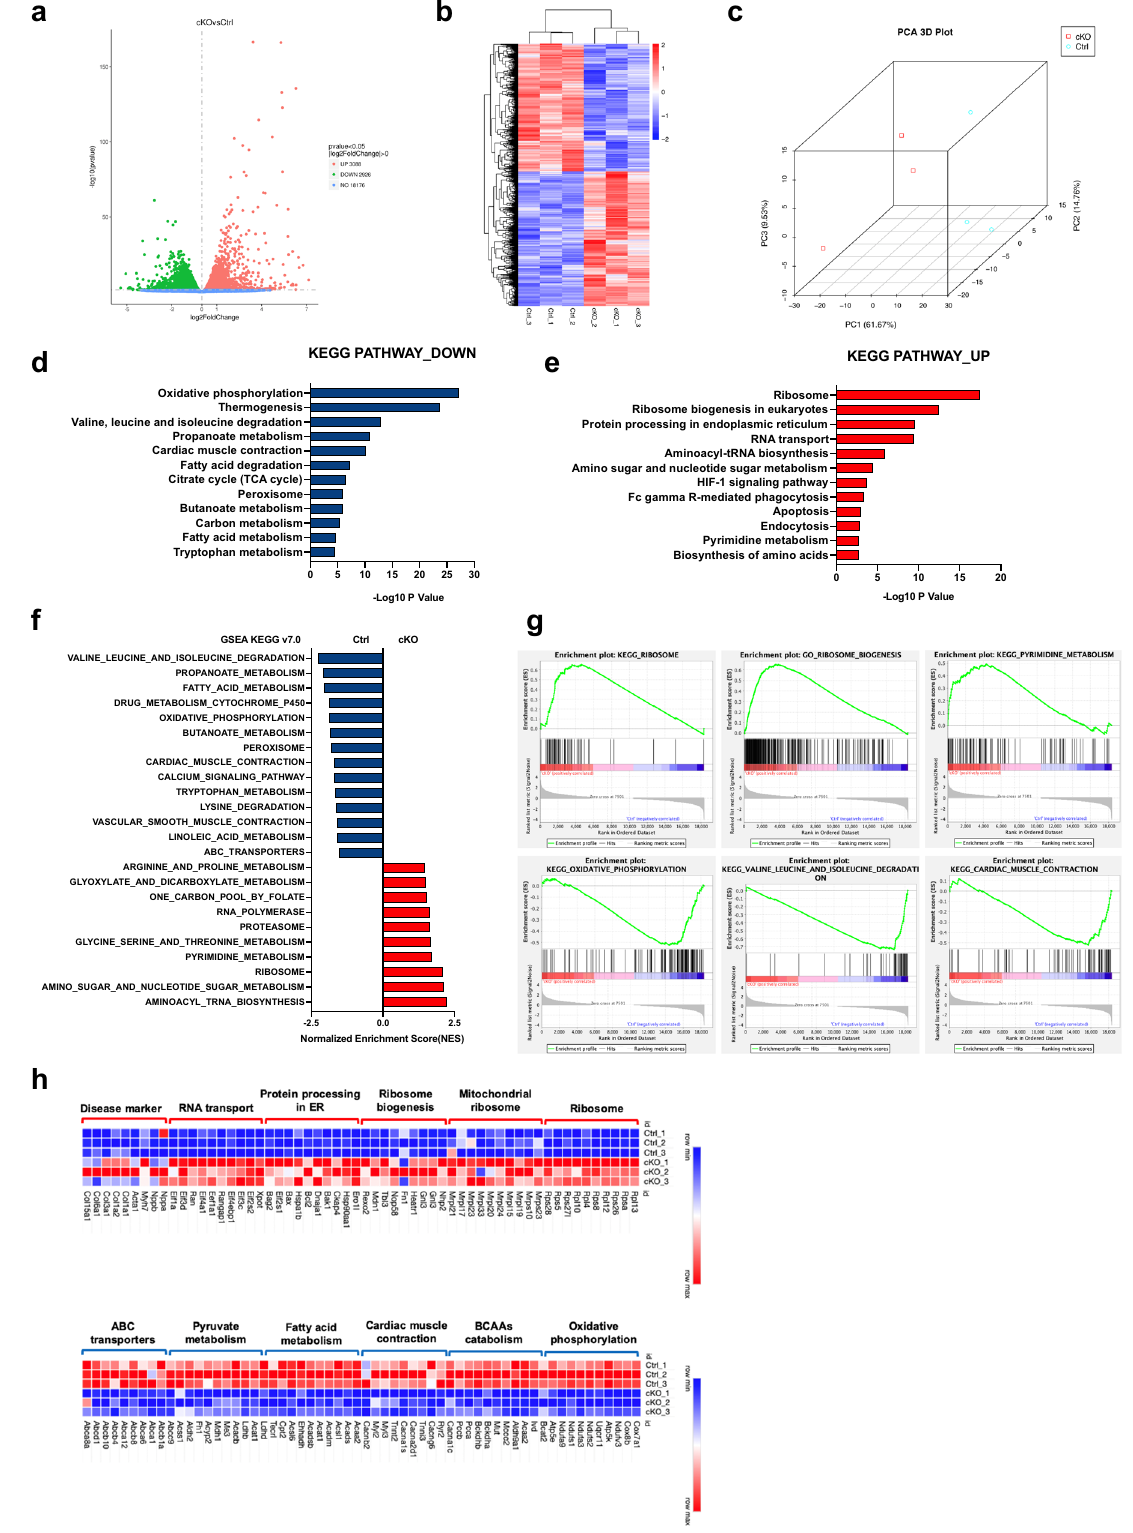
Fig. 3 | Lossof Mrps5 alters translational and metabolic programs inthe heart. a Volcano plot of dysregulated transcripts in Mrps5 cKO hearts by comparison with Mrps5 fl / fl hearts at 12 weeks following tamoxifen injection. b Hierarchical clustering heatmap of dysregulated transcripts in Mrps5 cKO hearts. n =3. c Principal compo- nent analysis (PCA) of gene expression in Mrps5 fl / fl and Mrps5 cKO hearts. n =3. d Kyoto Encyclopedia of Genes and Genomes (KEGG) functional enrichment